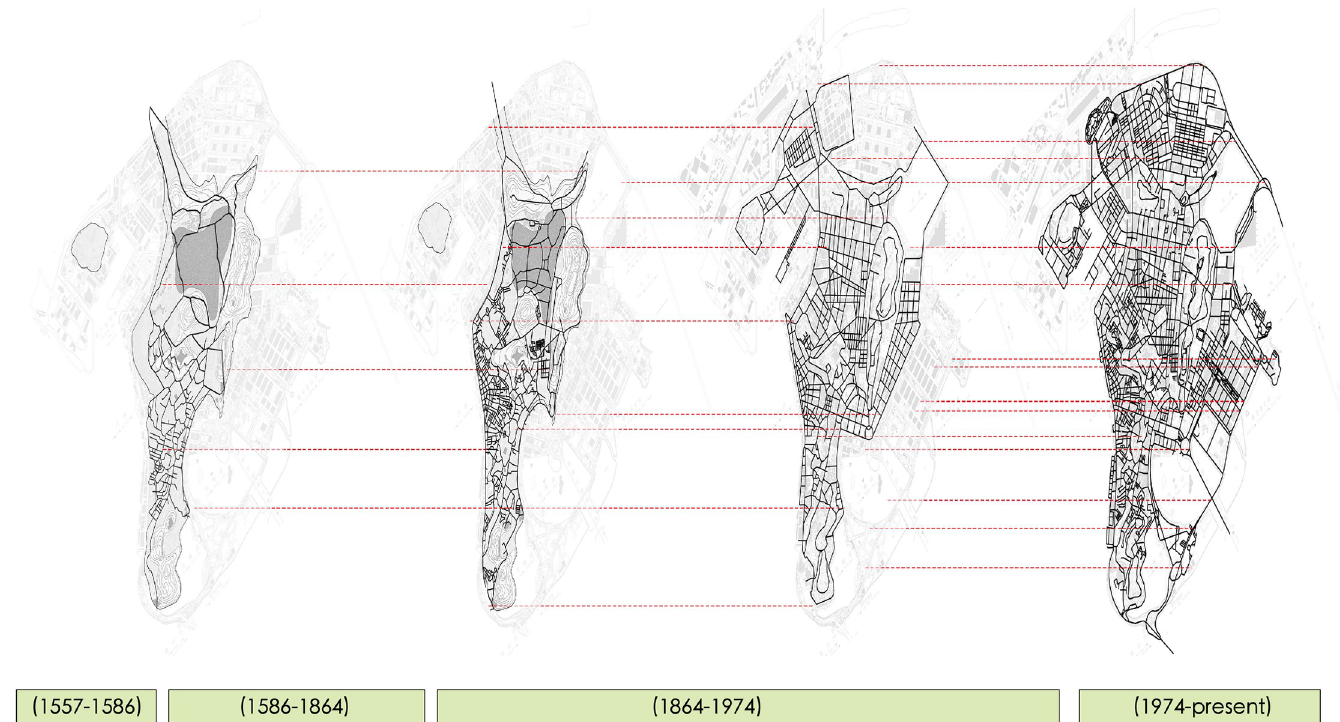
Fig 2. Road layering of the Macau Peninsula, based on drawings from maps of four different time